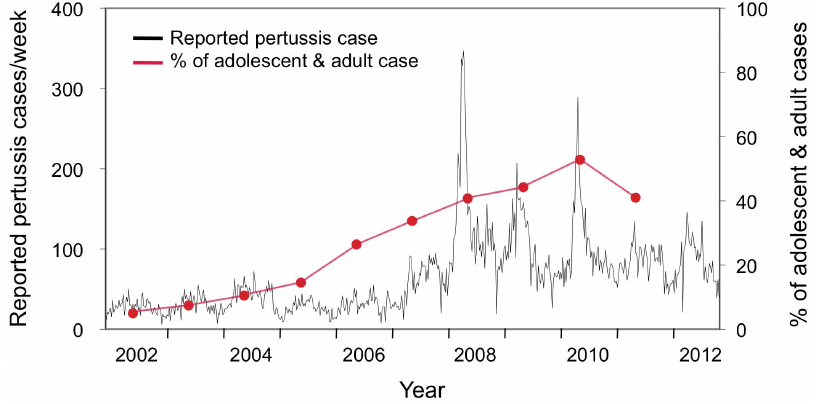
Figure 1. Number of reported pertussis cases per week in Japan from 2002 to 2012. Pertussis cases are shown by the black line, with each value representing a week of the year. The percentage of adolescent and adult cases ( $ 15 years old) per year is shown in red circles. The data were obtained from the Ministry of Health, Labor and Welfare of Japan Infectious Disease Surveillance data. Data regarding the number of adolescent and adult cases in 2012 were not